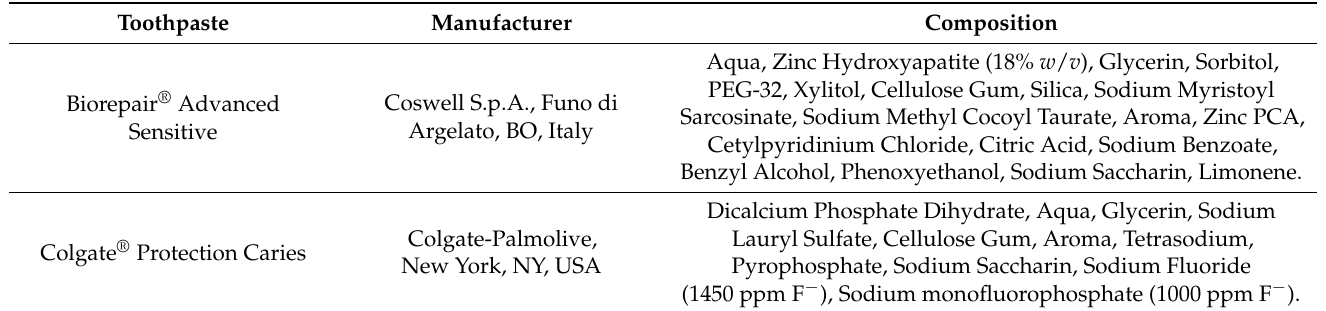
Table 1. Compositions of the materials used in the study.